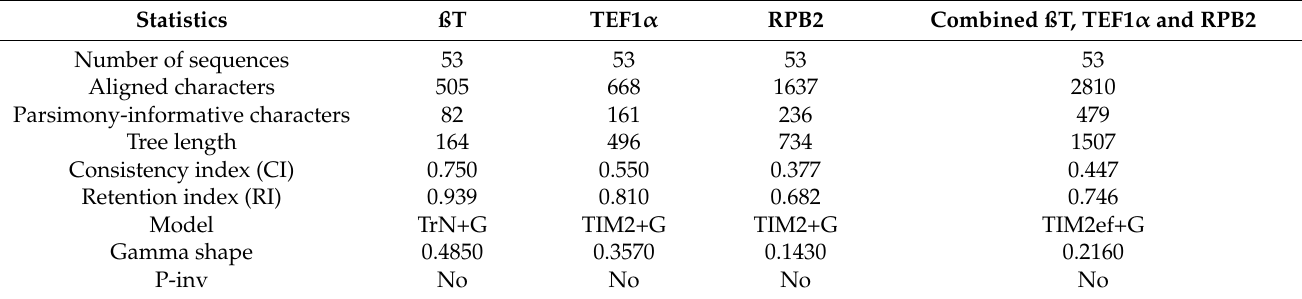
Table 2. Statistics resulting from maximum parsimony analyses and jModeltest